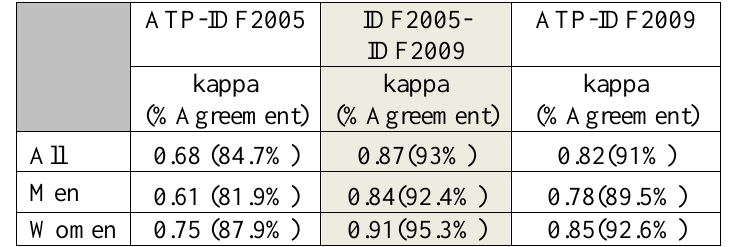
Table (5): kappa (%Agreement) between different definitions of the metabolic syndrome by gender